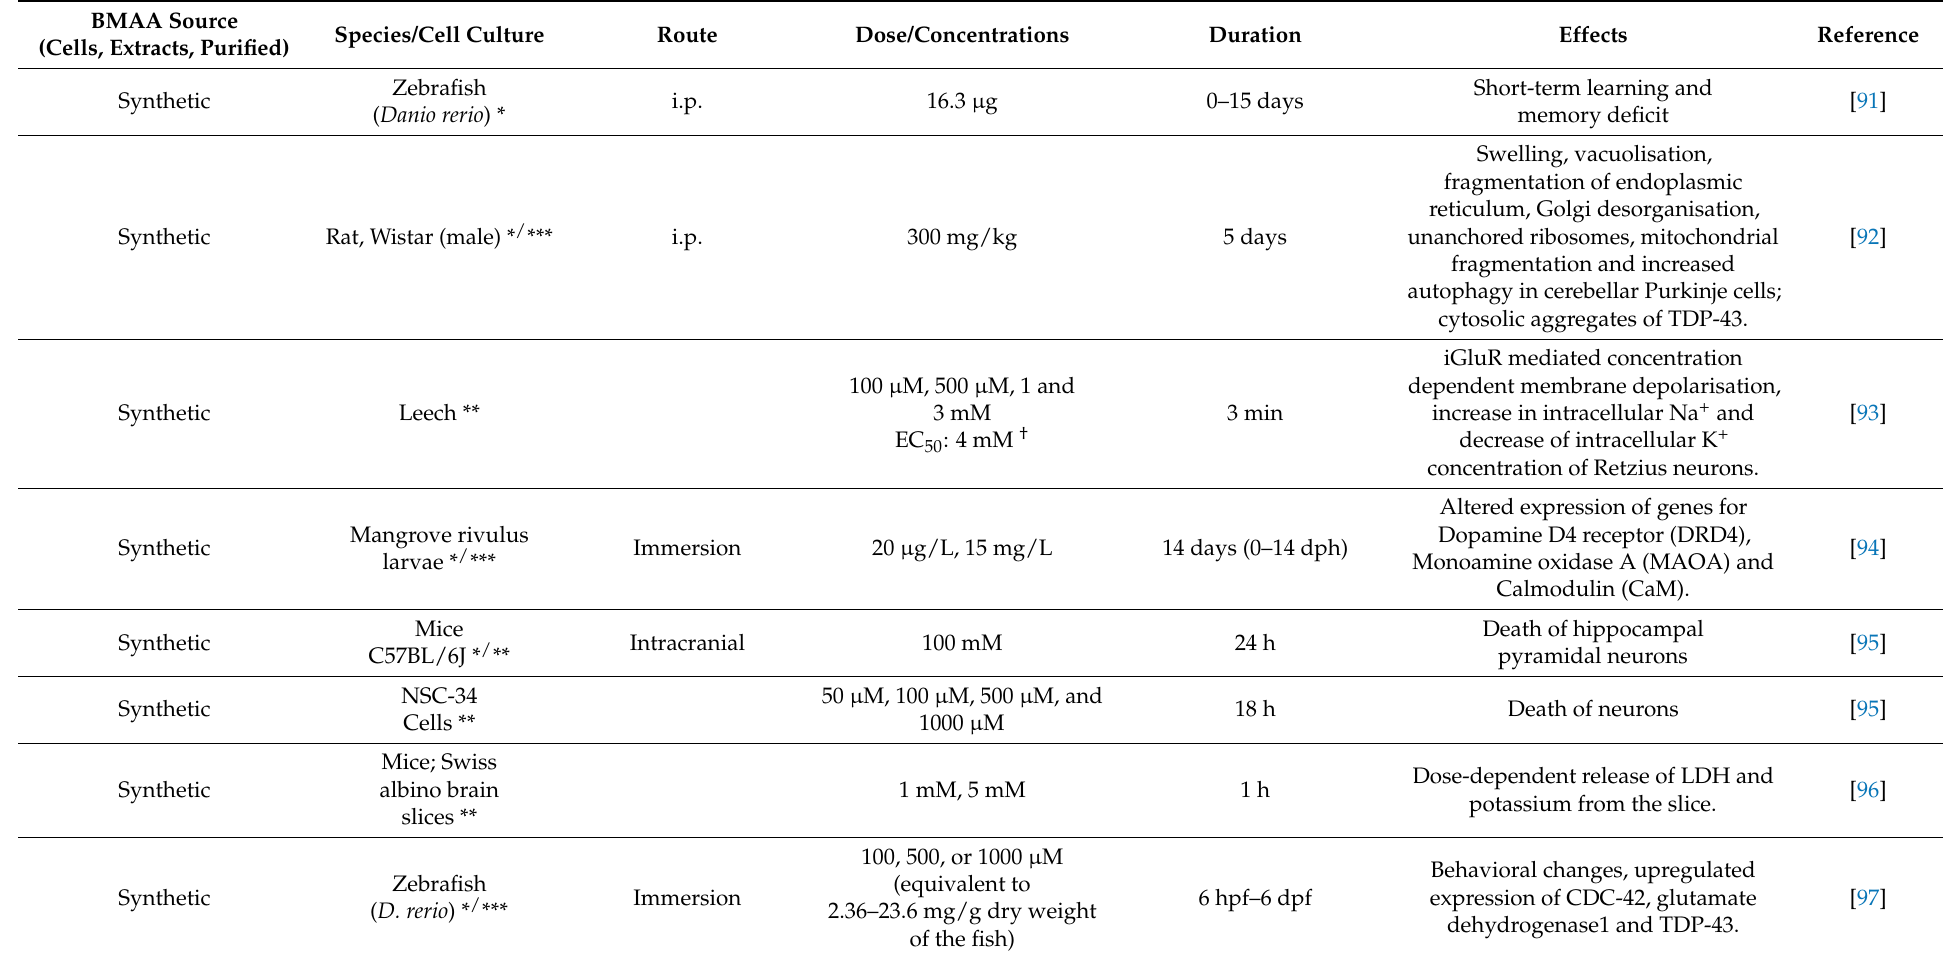
Table 1. Summary of studies on the effects/mechanisms of BMAA